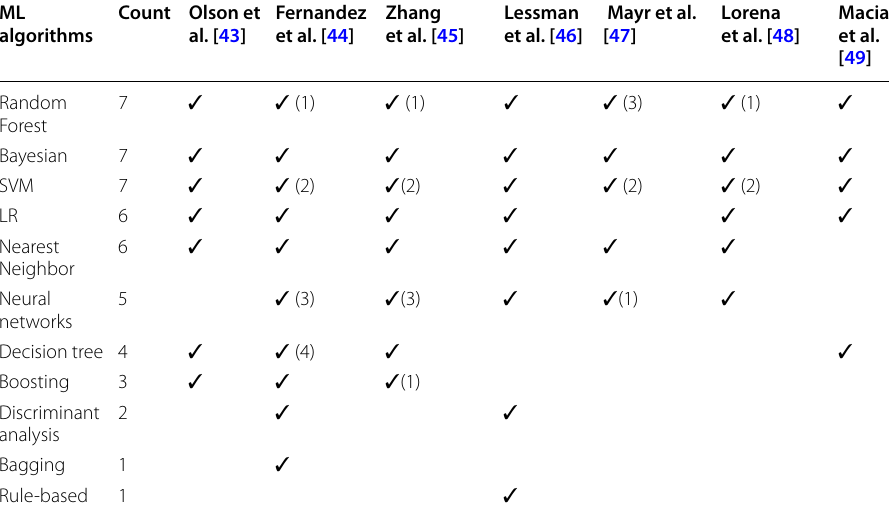
Table 1 Models that are used in other benchmark studies ML